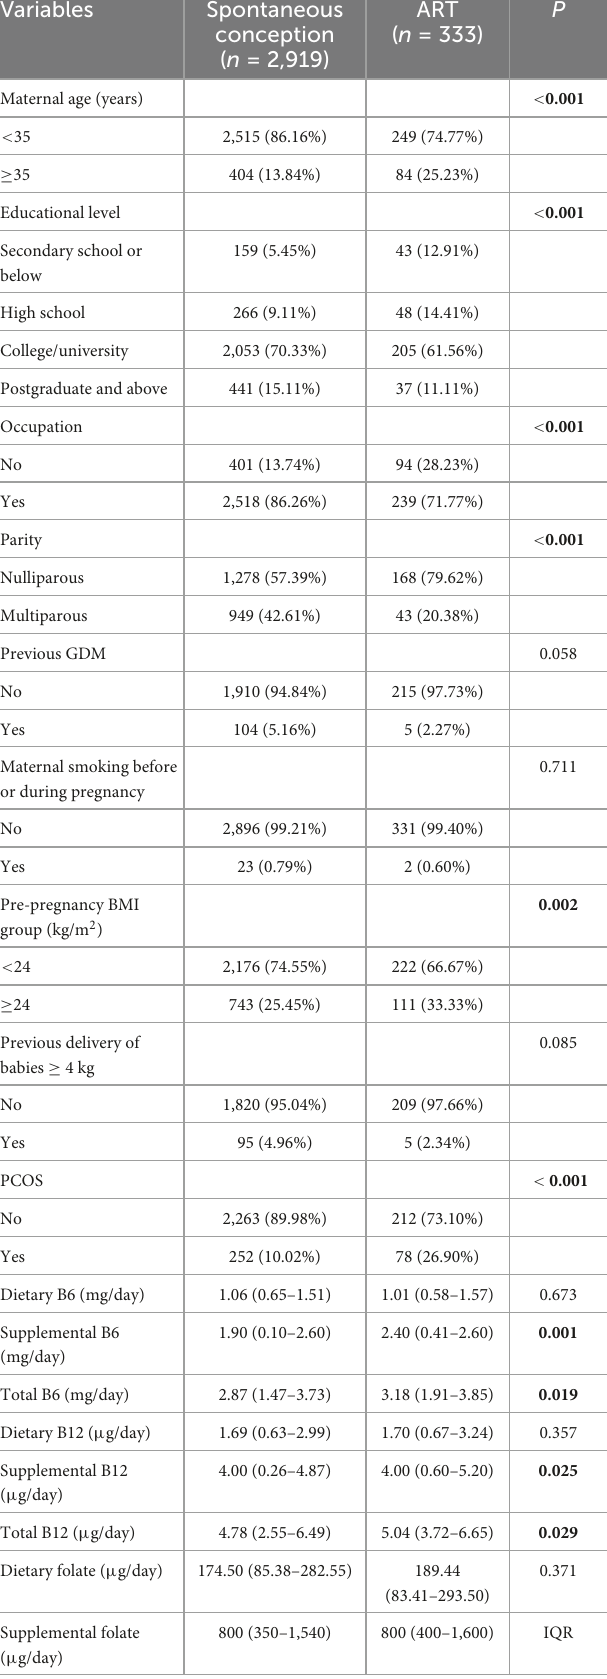
TABLE 1 Demographic characteristics of women with spontaneous conception and